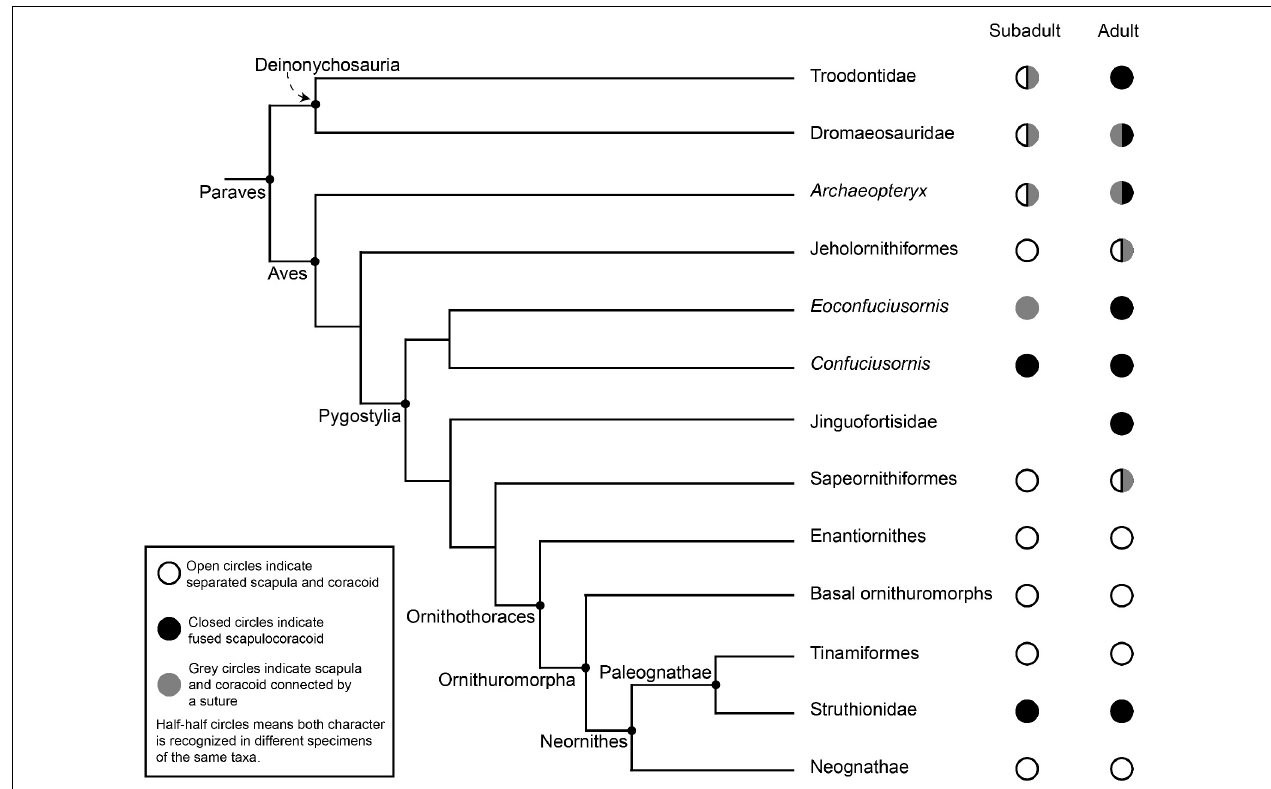
FIGURE 1 | A simplified cladogram of Paraves indicating the condition of the joint state between the scapula and coracoid, along with ontogenetic stage. Modified from O’Connor and Zhou